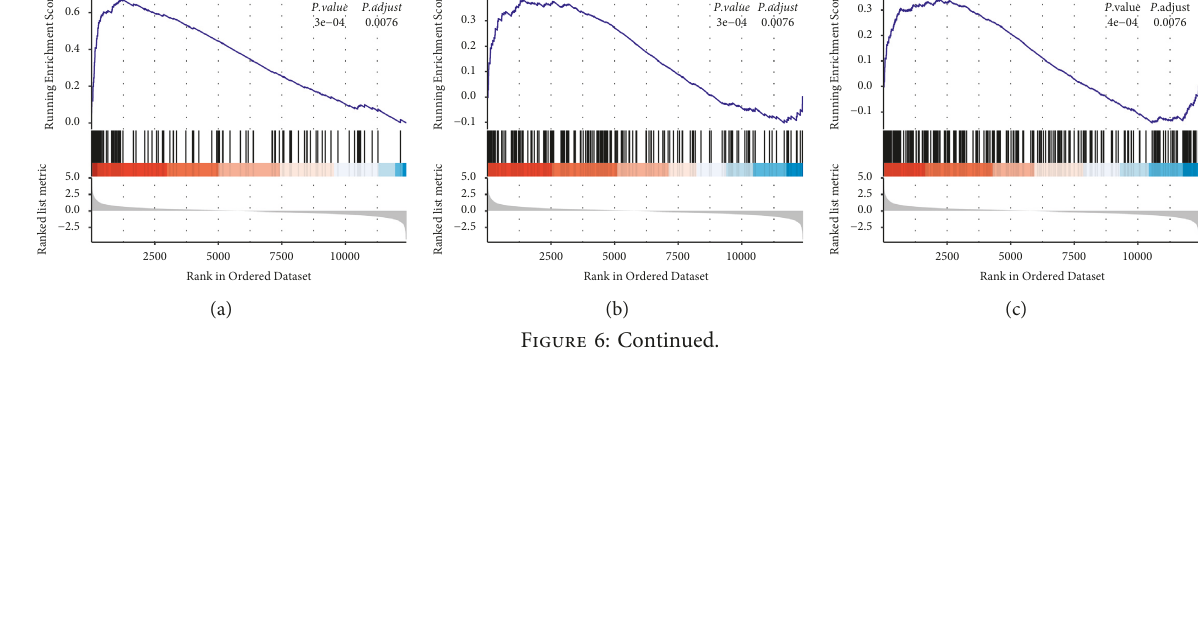
3e−04KEGG_CELL_CYCLE